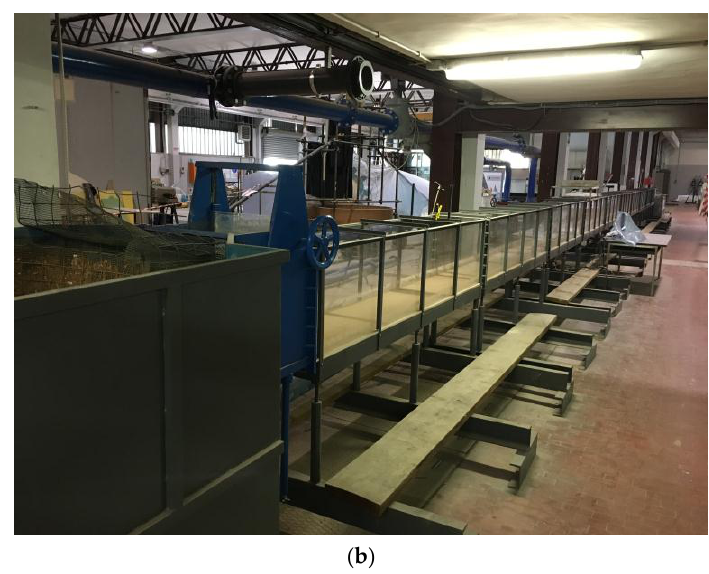
Figure 2. Channel at the Hydraulics laboratory of the Department of Civil, Environmental, Land, Building Engineering and Chemistry of the Polytechnic University of Bari: ( a ) sketch; and ( b ) picture of the channel.